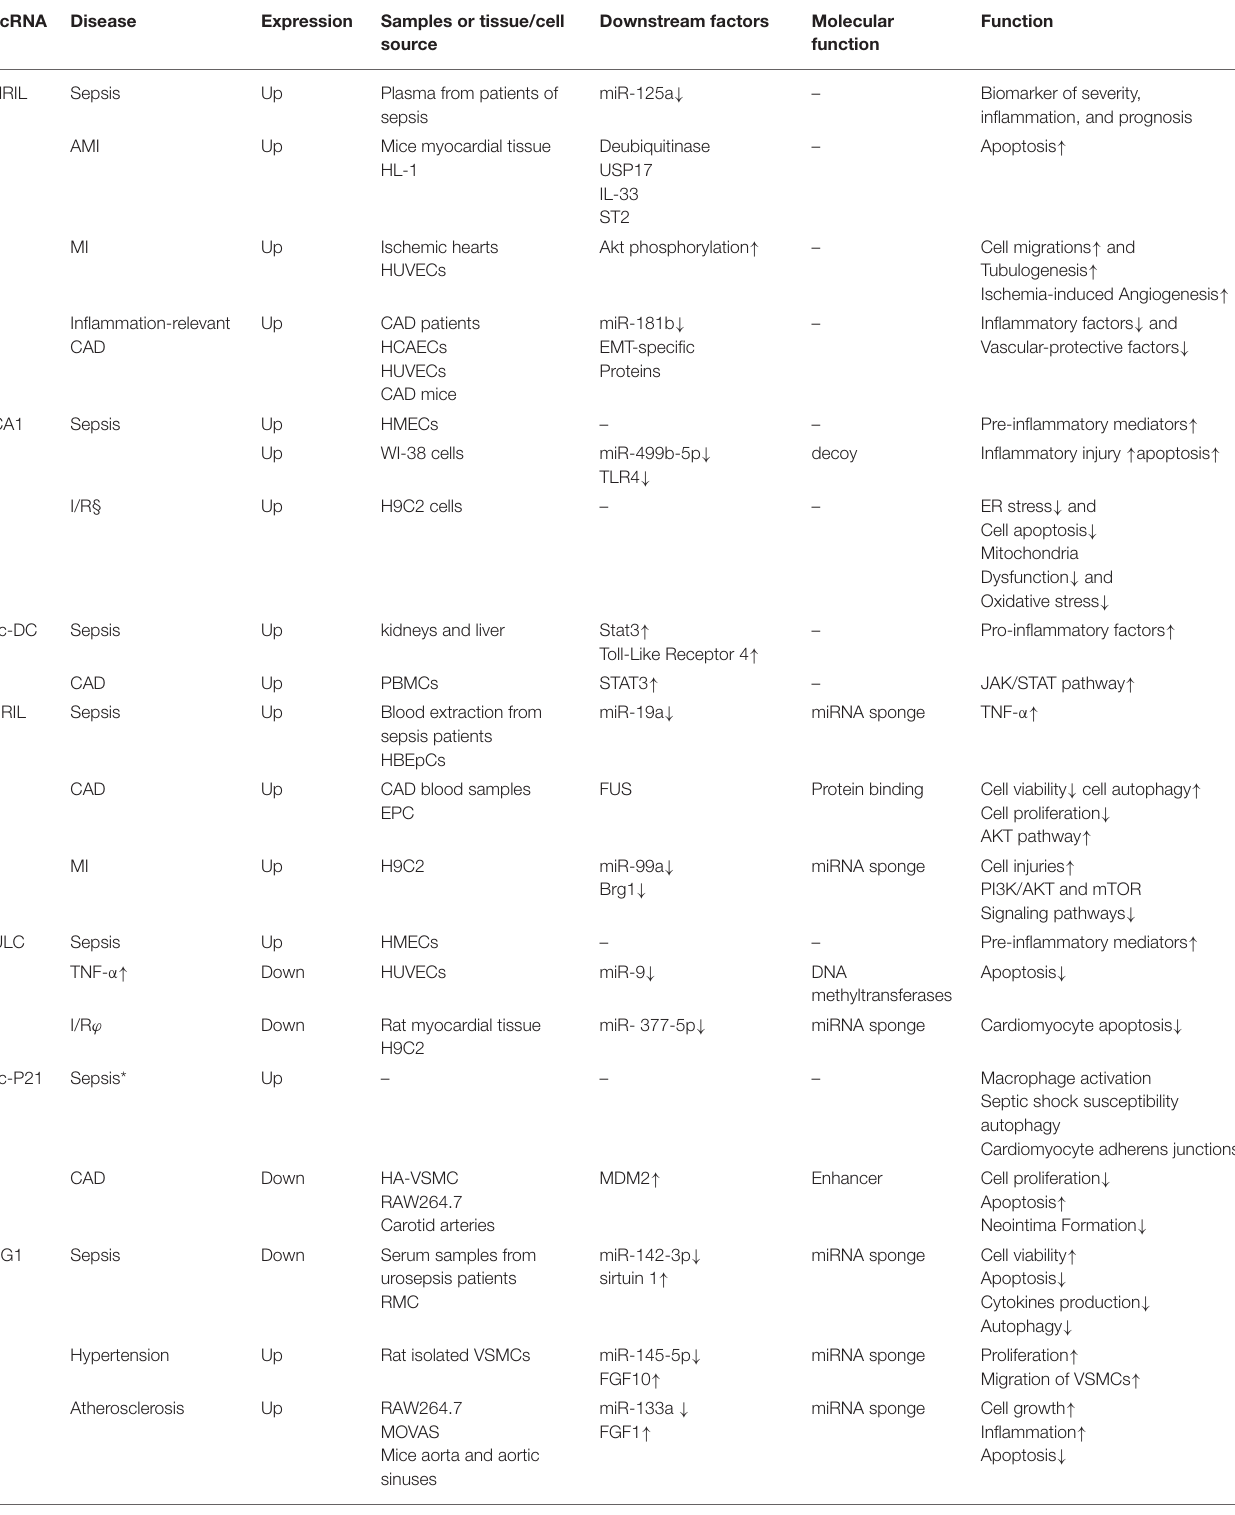
TABLE 2 | Summary of potential lncRNAs in SICD based on available evidence. LncRNA